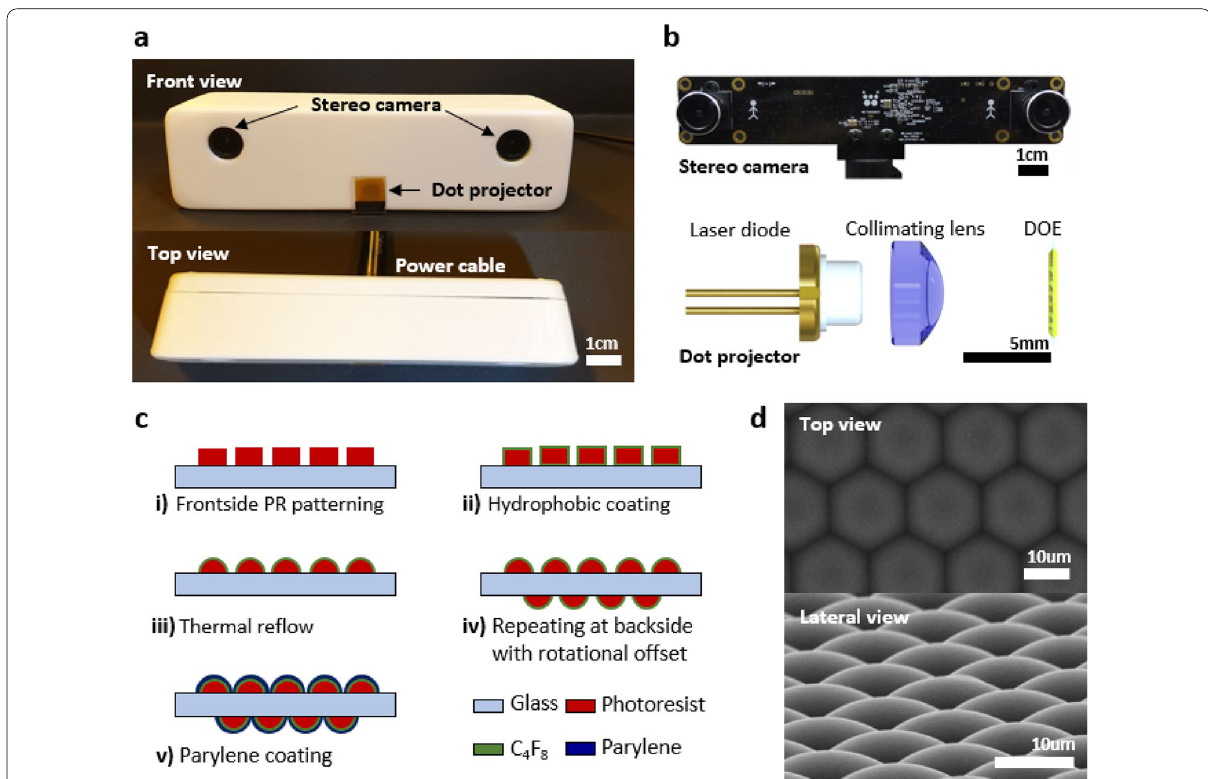
Fig. 2 Rotational offsetmicrolens arrays (roMLAs) and FRCM. a Fullypackaged FRCM. b The main components of the FRCM. A dot projector consists of alaser diode, a collimating lens, and a DOE. c Fabrication process of roMLAs. d SEM images of roMLAs